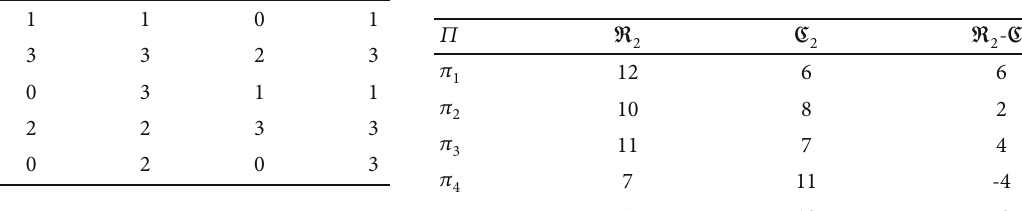
Table 8: The second positive pole score table.